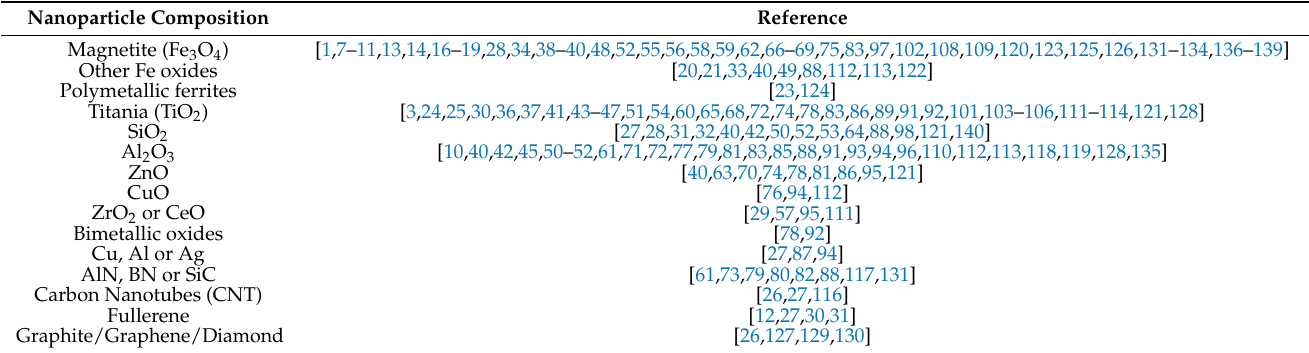
Table 3. Composition of nanoparticles that were used in references.